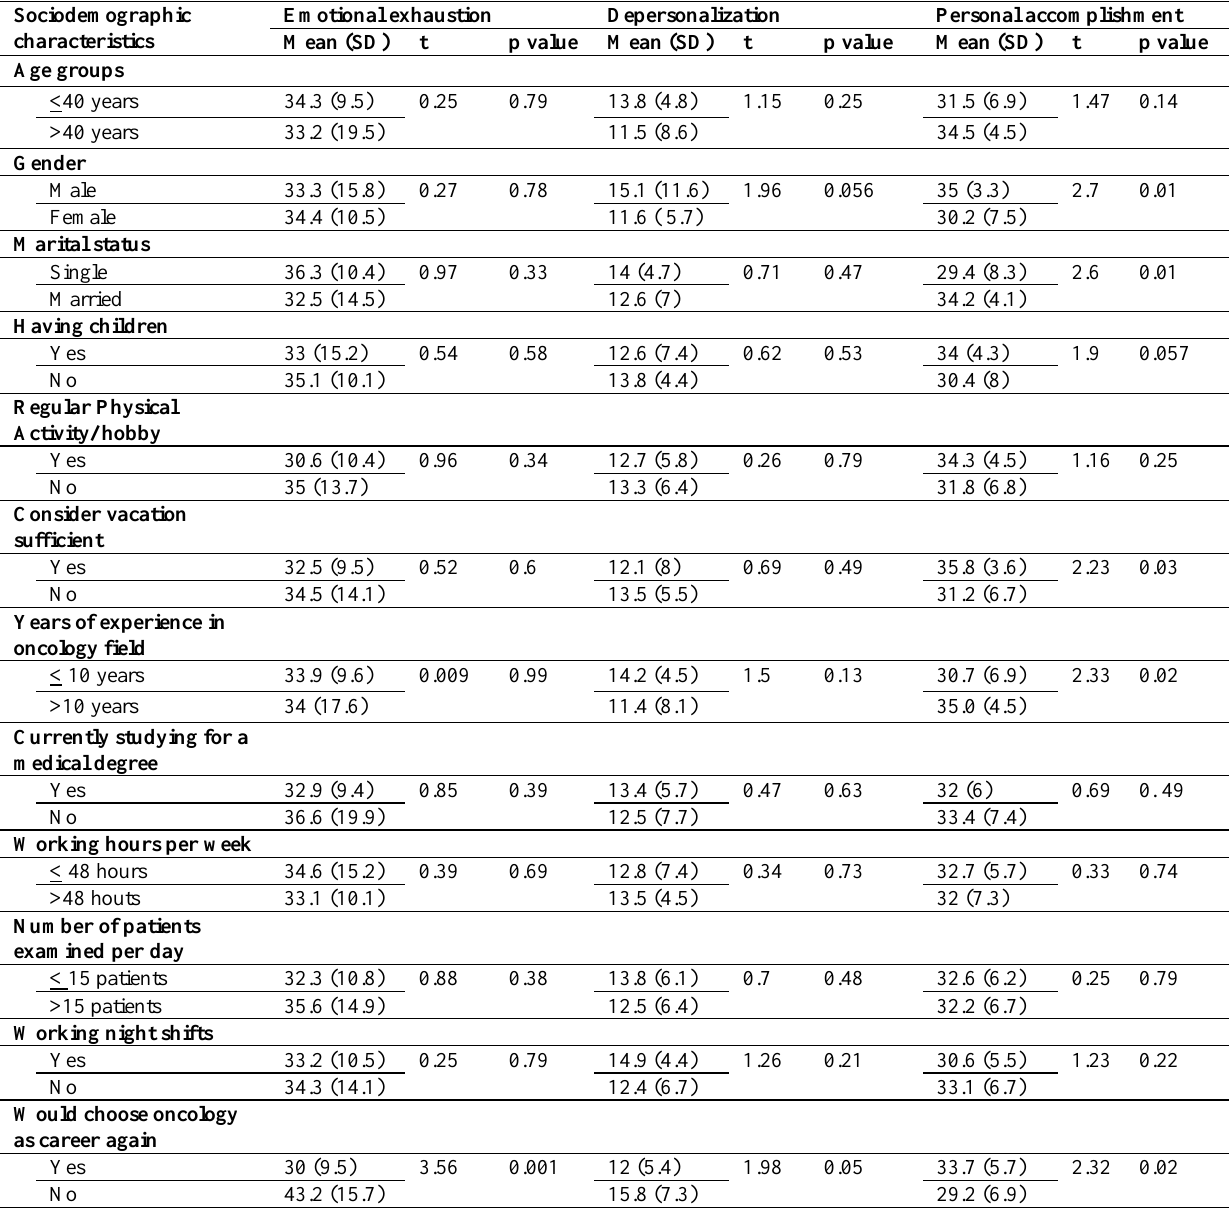
Table 4: Mean MBI subscale scores according to participants’ socio-demographic and job characteristics